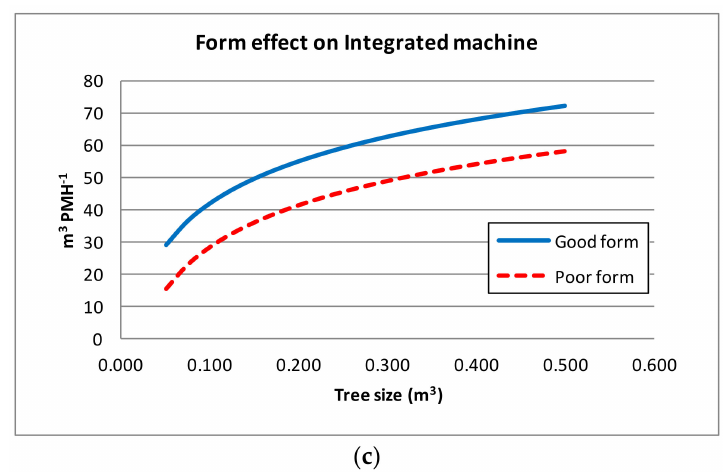
Figure 3. Relationship between productivity, tree size, and other relevant variables. ( a ) Machine type effect for goodform and low BWBS (bark–wood bond strength), ( b ) BWBS effect on integrated machine, ( c ) Form effect on integrated